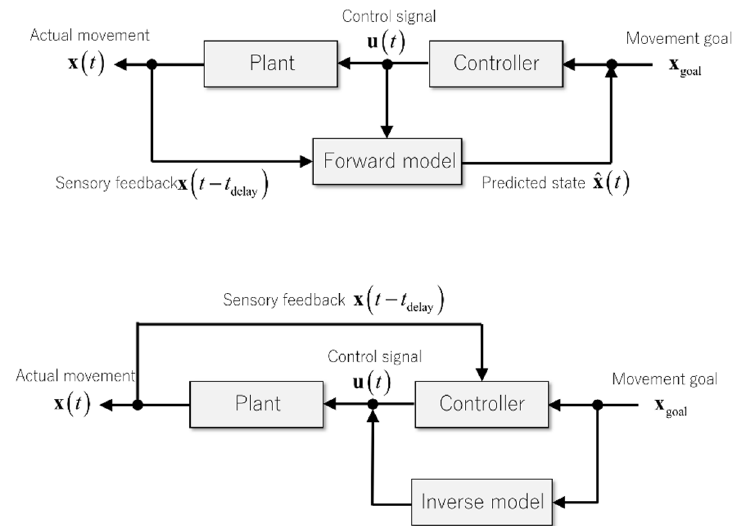
Figure 6. Computational diagrams of internal models. An internal forward model integrates sensory feedback signals and an e ff erence copy of a control signal and predicts the current status of the body (top). In contrast, an internal inverse model produces control signals designed to achieve a given movement goal (bottom). Note that the outputs of a forward and an inverse model reside in the sensory and the motor coordinates,